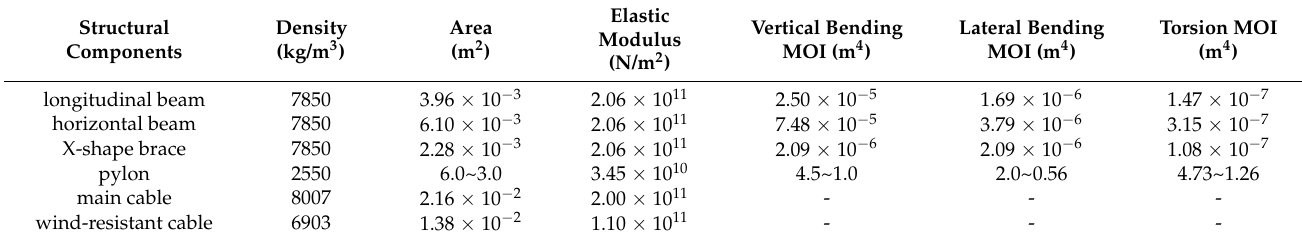
Table 1. Main structural parameters of the bridge.